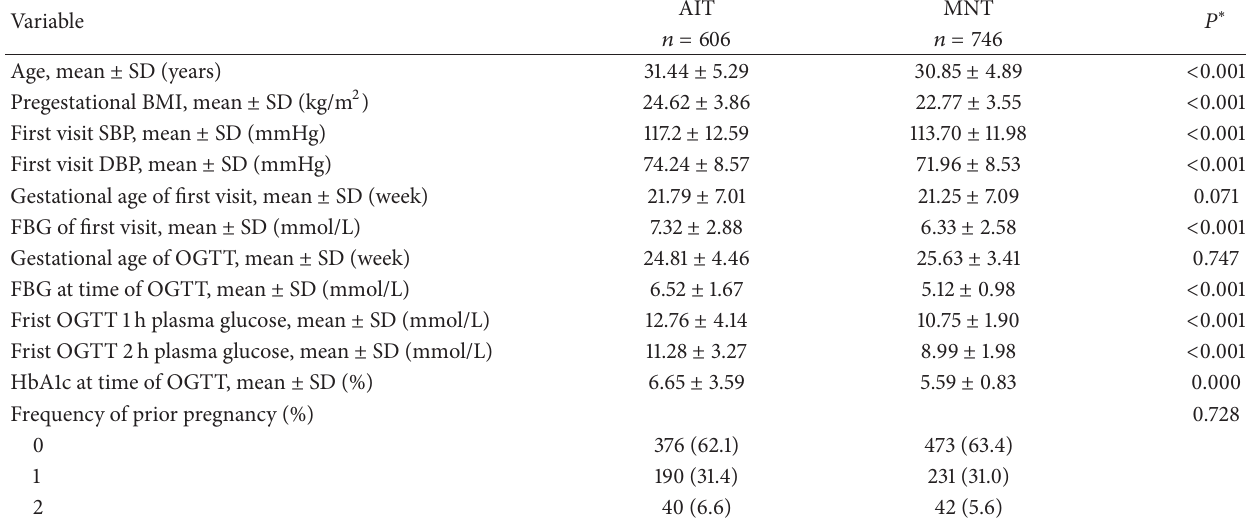
Table 1: Clinical variables and characteristics of patients with AIT and those with MNT